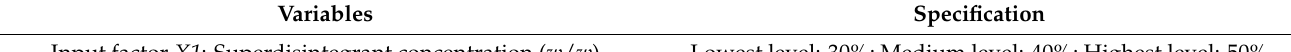
Table 1. An overview of the response surface design for optimising CBZ ODMT formulations. Variables